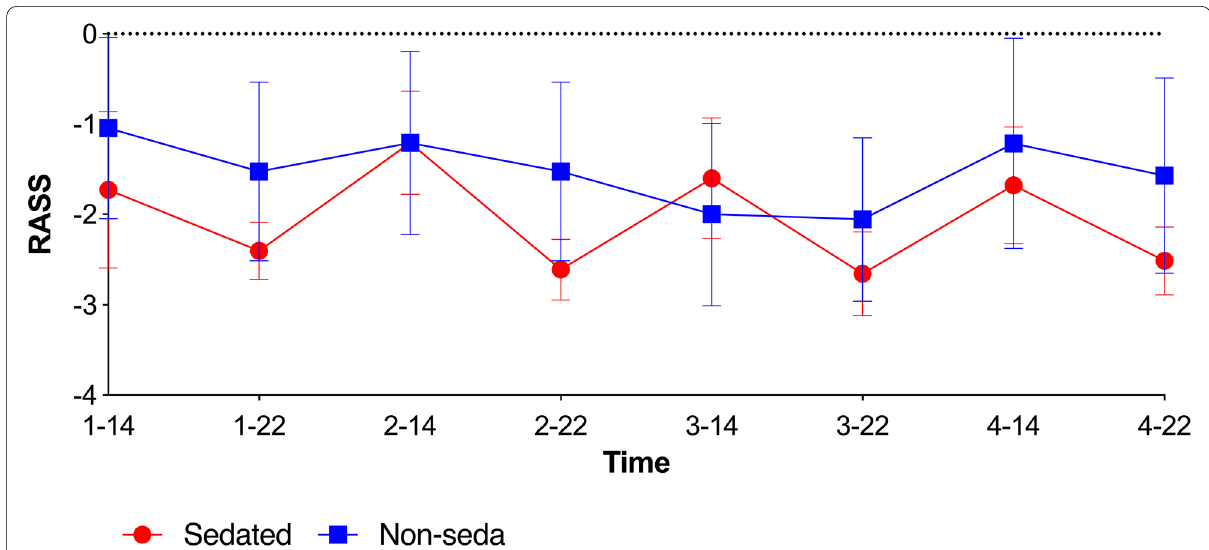
Fig. 3 Mean RASS score throughout the 4-day study period including 95% confidence